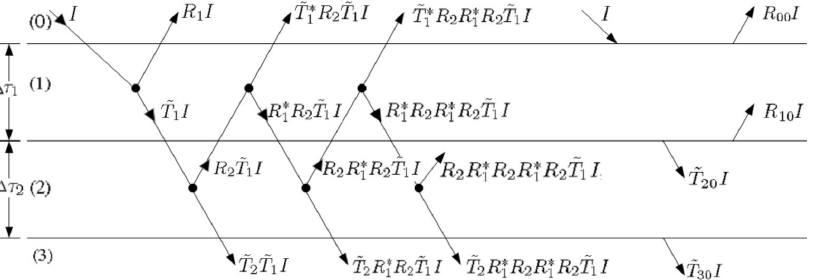
Figure A1. Two-layered model characterized with local reflections, local transmissions, combined reflections and combined transmissions